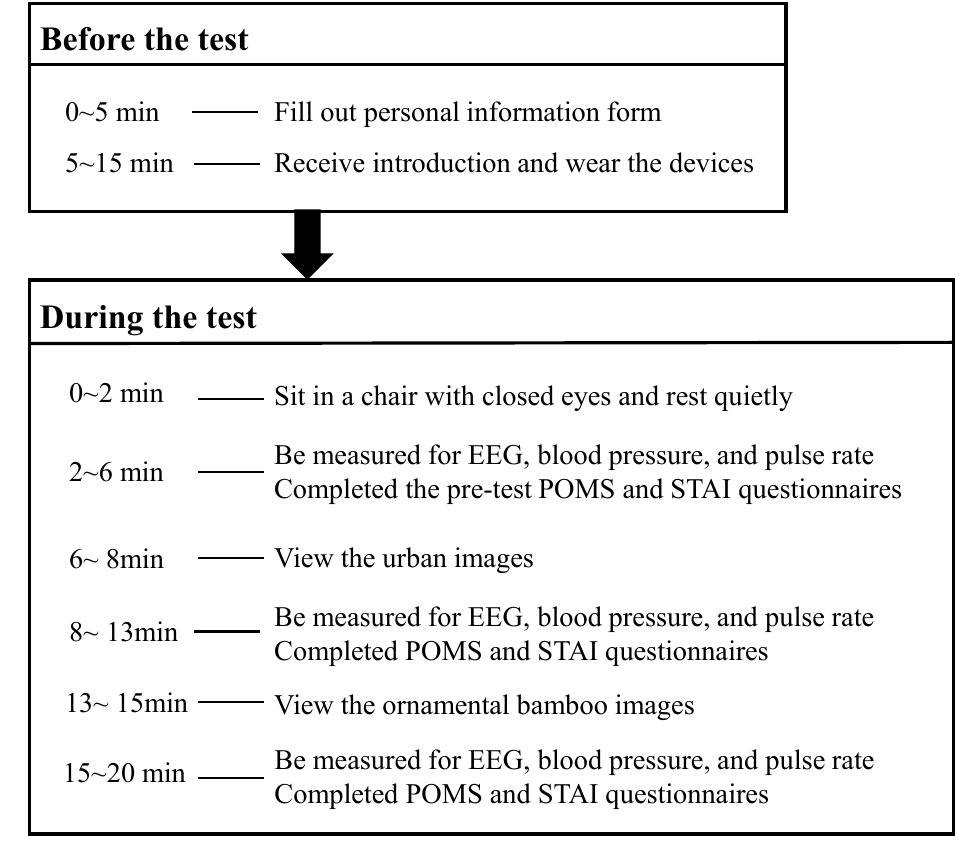
Figure 2. Experimental Design.